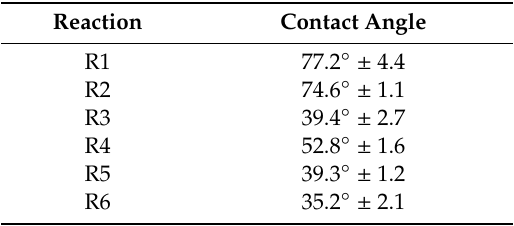
Table 3. Contact Angle of the final polymer products.